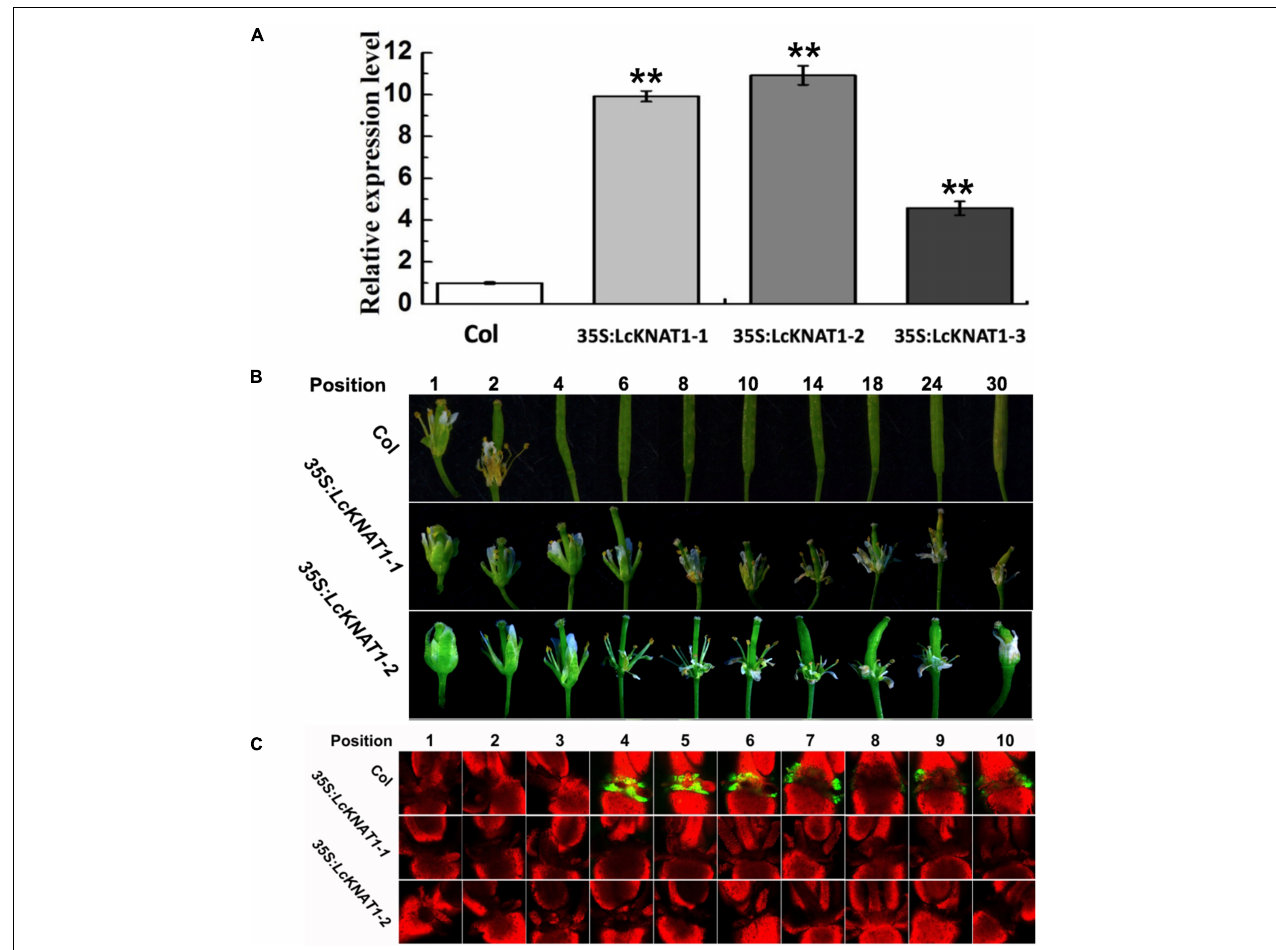
FIGURE 5 | Ectopic expression of LcKNAT1 in Arabidopsis suppresses floral organ abscission. (A) The expression levels of LcKNAT1 in Arabidopsis transgenic lines. LcKNAT1 driven by the CaMV 35S promoter was transformed into wild-type Arabidopsis . (B) Phenotypes of floral organ abscission process in Col and LcKNAT1 transgenic lines. Floral organ position numbers were counted from the first flower with visible white petals on the top of the inflorescence. (C) BCECF fluorescence micrographs of floral organ AZ in Col and LcKNAT1 transgenic lines. Inflorescence samples were separated from the plant body, incubated in BCECF-AM staining, and then examined using the confocal laser scanning microscope. Merged images of BCECF fluorescence with chlorophyll autofluorescence were shown, which are representative images out of 3–4 replicates. Asterisks indicate a significant difference (Student’s t -test: ** P < 0.01).